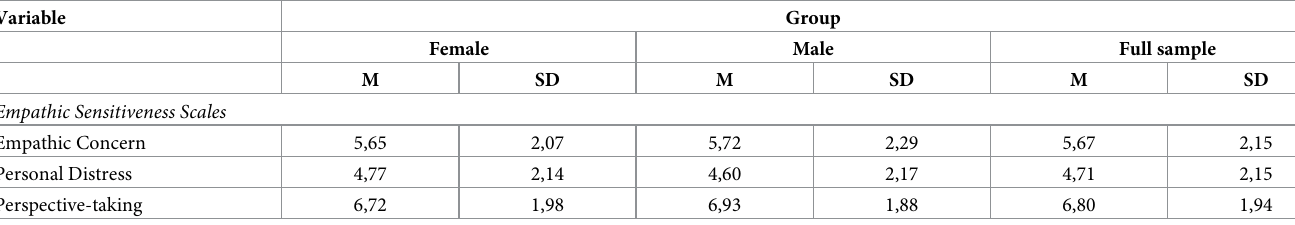
Table 2. Mean and SD for Empathic Sensitiveness Scale residualized